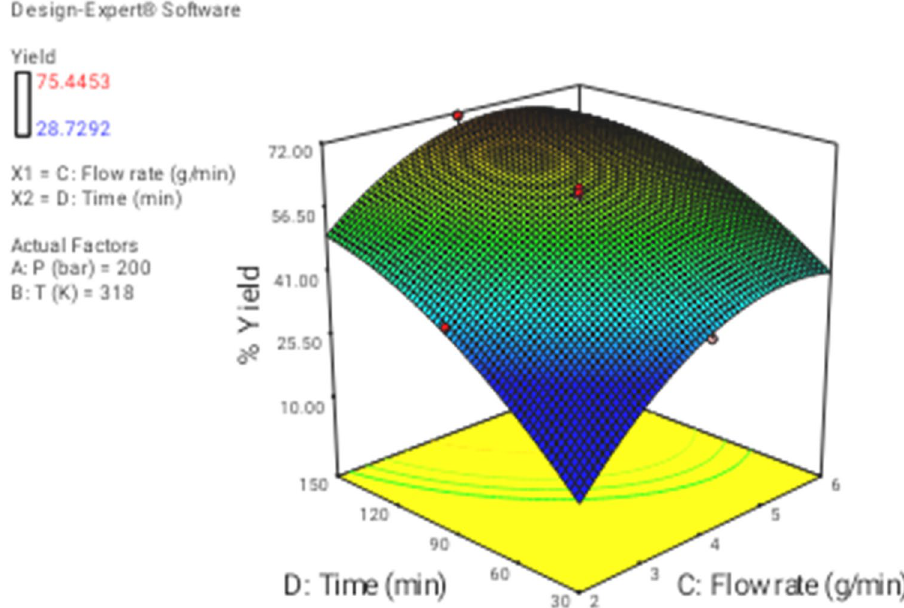
Figure 8. 3D graphic surface for the effects of flow and time on the yield.